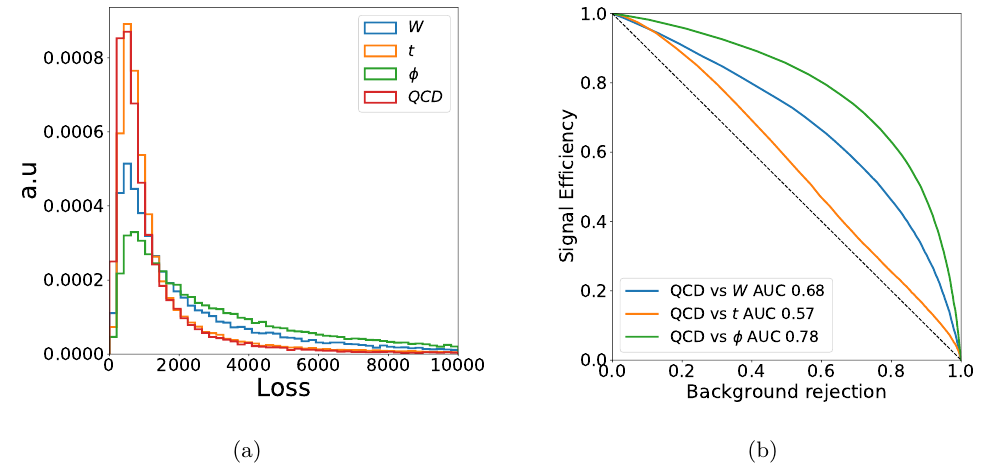
Figure 8 . Distribution of the loss function of the PGAE (a) and the corresponding ROC curves (b) for the different signal classes for a network trained only on QCD